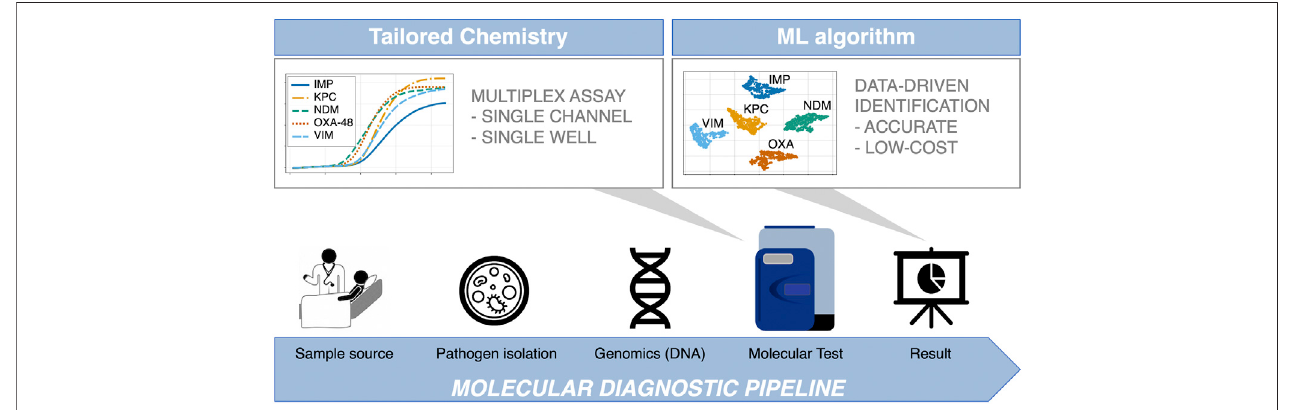
FIGURE 1 | Integration of data-driven approaches to standard diagnostic work fl ows. The blue arrow indicates the conventional diagnosis pipeline from patient to result, where patient sample is collected from different sources (e.g., eye swab, nasopharyngeal swab, throat swab, urine, or rectal swab). Subsequently, samples are cultured, and nucleic acids are extracted in a microbiology lab. Following this, the most suitable genetic test is developed in-silico, comprising of specialised assays capable of multi target detection in a single reaction ( fi rst grey arrow). The test is performed in the dPCR instrument, outputting large amounts of data, which are analysed by a machine learning supported algorithm to ensure reliable and accurate results (second grey arrow). This is where the AMCA methodology is